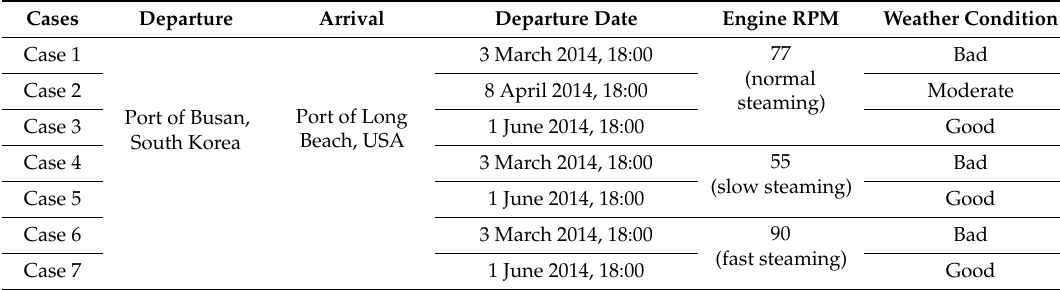
Table 3. Summary of cases for the